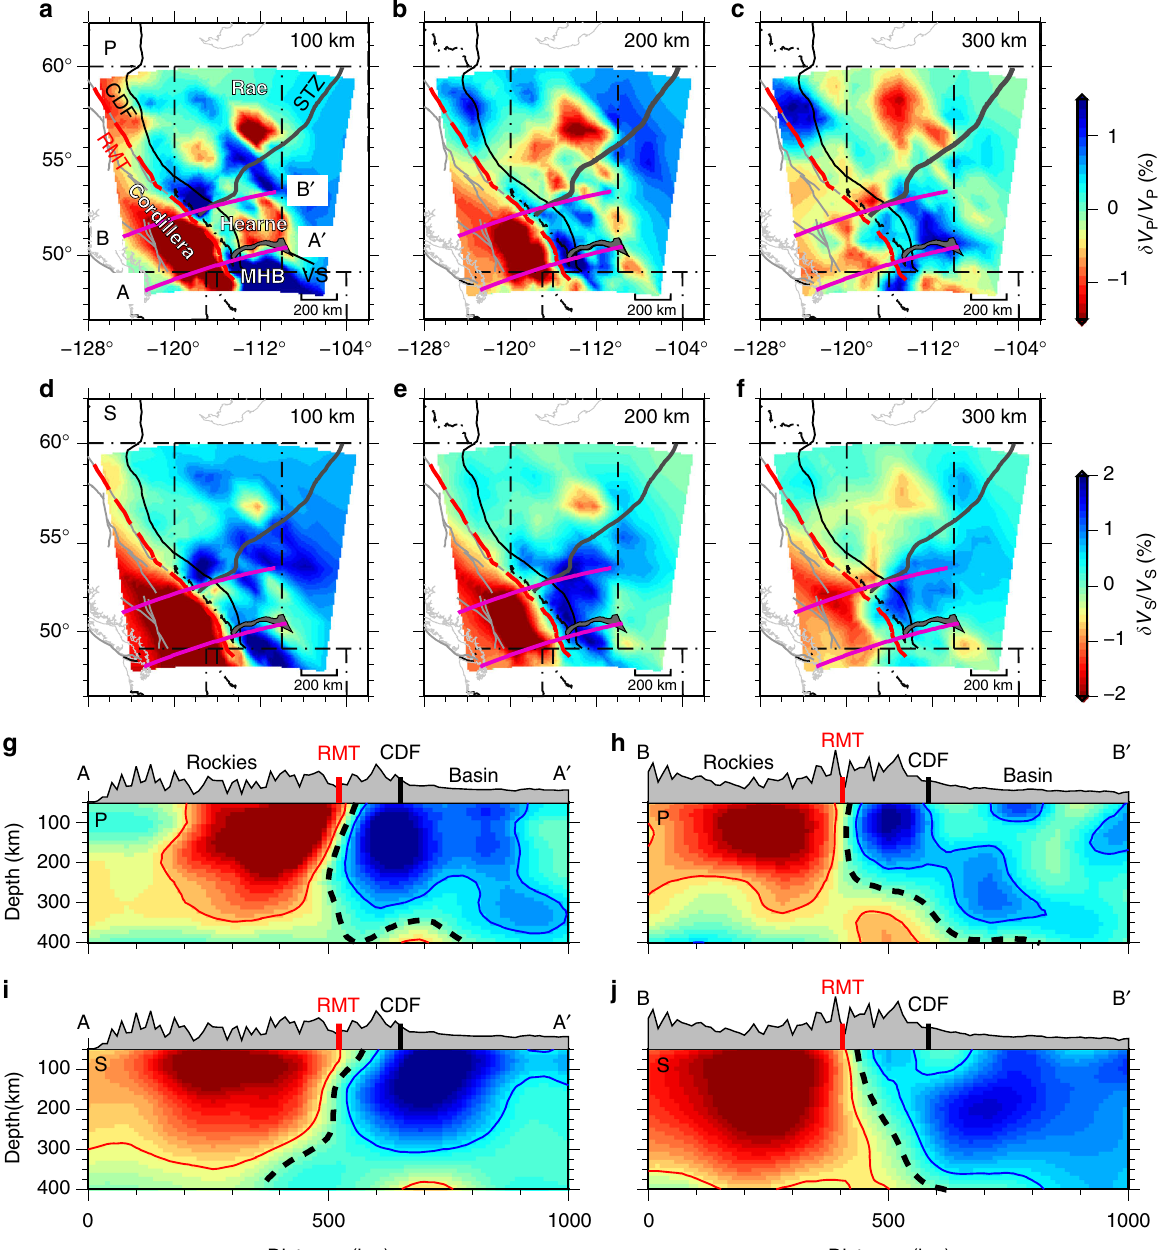
Fig. 2 P-wave and S-wave velocity anomalies resolved from fi nite-frequency tomography. a – c P-wave velocities at 100, 200, and 300 km depths, respectively. d – f The same as a – c but for S-wave velocities. The locations of two velocity pro fi les are shown by the purple lines at 100 km depth. The red dashed line marks the Rocky Mountain Trench. g , h P-wave velocity anomalies along two pro fi les in the southern Canadian Cordillera. i , j The corresponding S-wave velocity variation along the two pro fi les. The southern (AA ′ ) and northern (BB ′ ) pro fi les intersect with the Rocky Mountain Trench at about 50° and 52° N, respectively. The locations of the Rocky Mountain Trench and Cordilleran Deformation Front are respectively marked by the red and black lines at the surface. The black dashed line indicates the zero percent velocity contour, which approximates the location of the Cordillera –